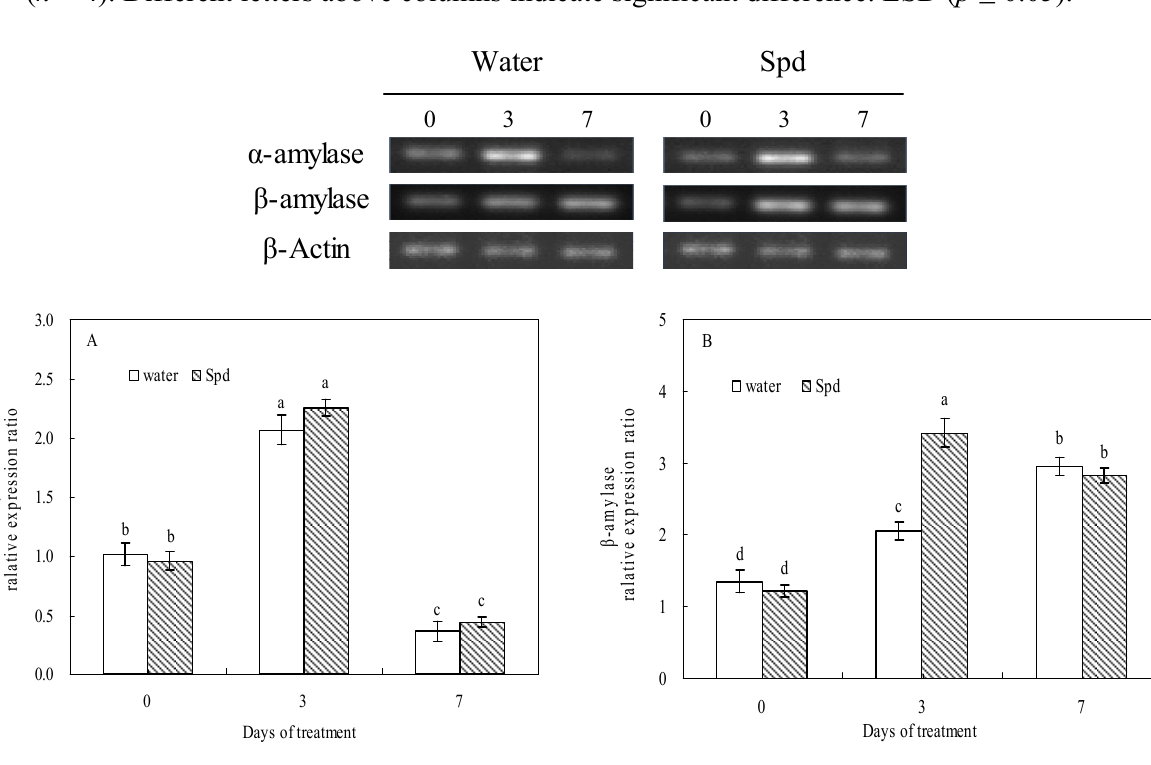
Figure 3. The effect of seed soaking with water or spermidine (Spd) on ( A ) α -amylase gene and ( B ) β -amylase gene relative expression ratio in the process of seeds germination (7 days) under water stress induced by 15% PEG. Vertical bars indicate ± SE of mean ( n = 4). Different letters above columns indicate significant difference. LSD ( p ≤